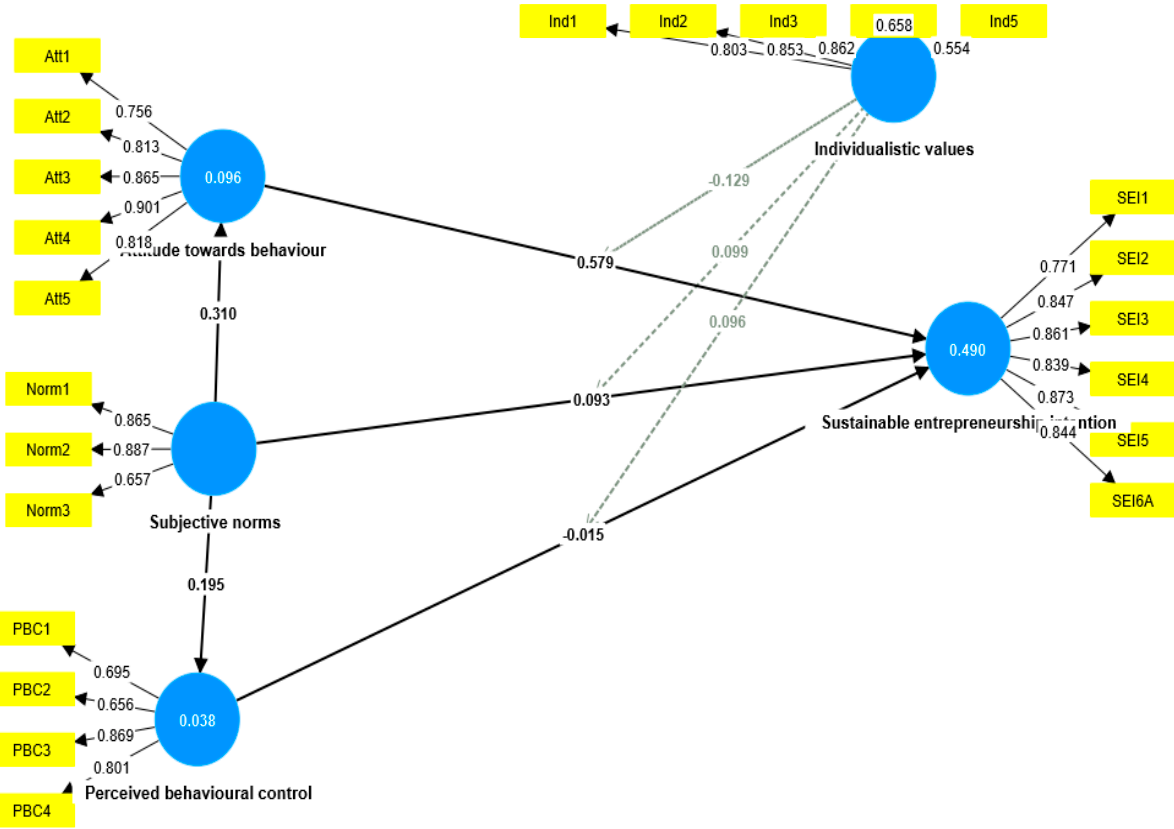
Figure 2. Model test results.